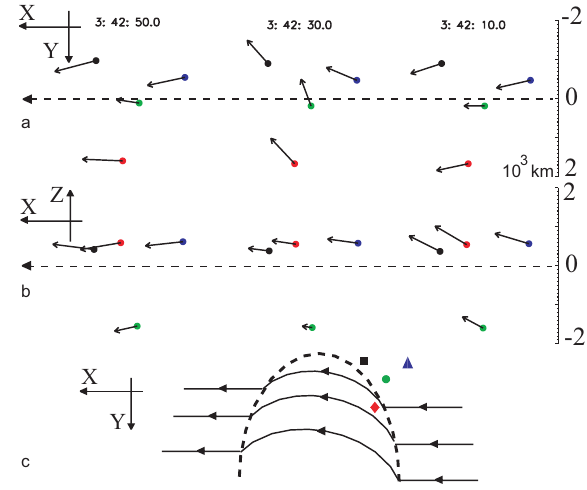
Fig. 6. Interval A 1: Magnetic field observations in the variance frame. Time is in seconds after 03:41:40UT.